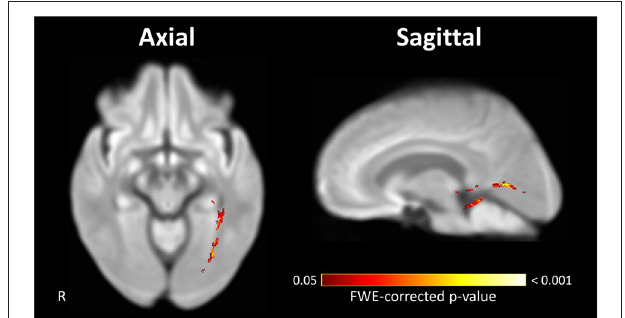
FIGURE 4 | Significant difference in the rate of FD loss exhibited by visual pathways of POAG patients compared to controls. The left OR of POAG patients showed a significantly higher rate of FD loss compared to the controls. Streamlines corresponding to fixels exhibiting a significant (FWE-corrected P < 0.05) difference between groups are overlaid on representative axial (left) and sagittal (right) slices of the inter-subject population template and colored according to their p -values. Images are shown in radiologic convention. FD, fiber